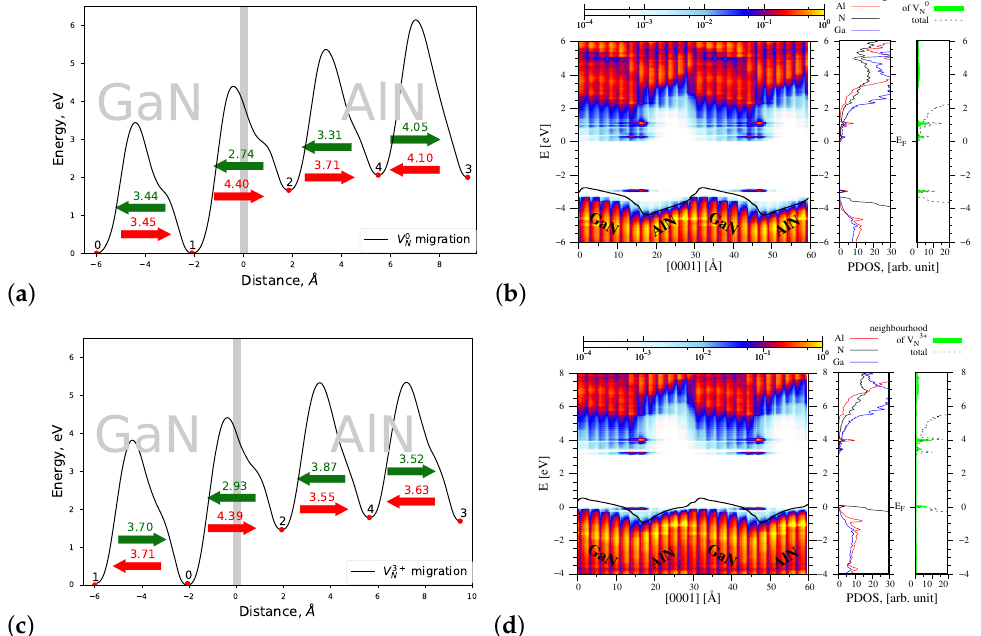
Figure 10. Left—joint profiles of the migration energy barrier of nitrogen vacancy V N at the AlN/GaN interface, right—the density of states projected on the atom quantum states (P-DOS), showing the spatial variation of the valence and conduction bands in the GaN/AlN and the total DOS is denoted by black dashed line; DOS associated with Al, N, and Ga atoms are denoted by red, black, and blue line, respectively; The green shade represents sum of the PDOS from the nearest neighbors of V N . ( a , b ) V 0 , the corresponding potential jump ∆ V = 0.90 eV ( c , d ) V 3 + N jump ∆ V = 0.66